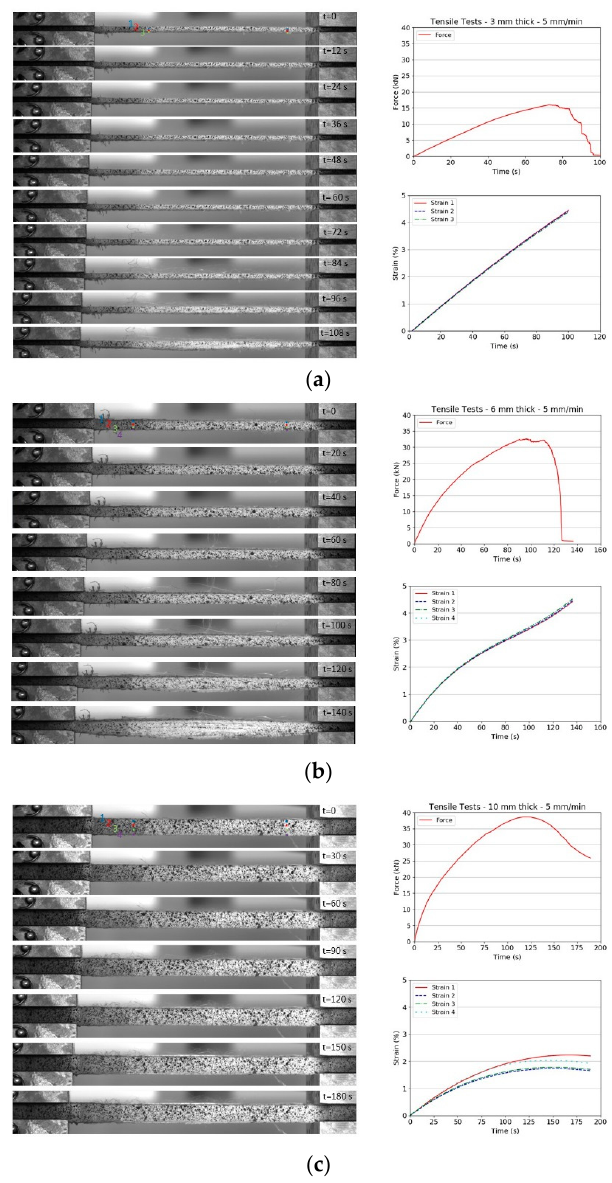
Figure 5 . Snapshots from tensile tests and force and time history plots for Dyneema ® HB26 laminates with different thickness: ( a ) 10 mm; ( b ) 6 mm; ( c ) 3 mm.